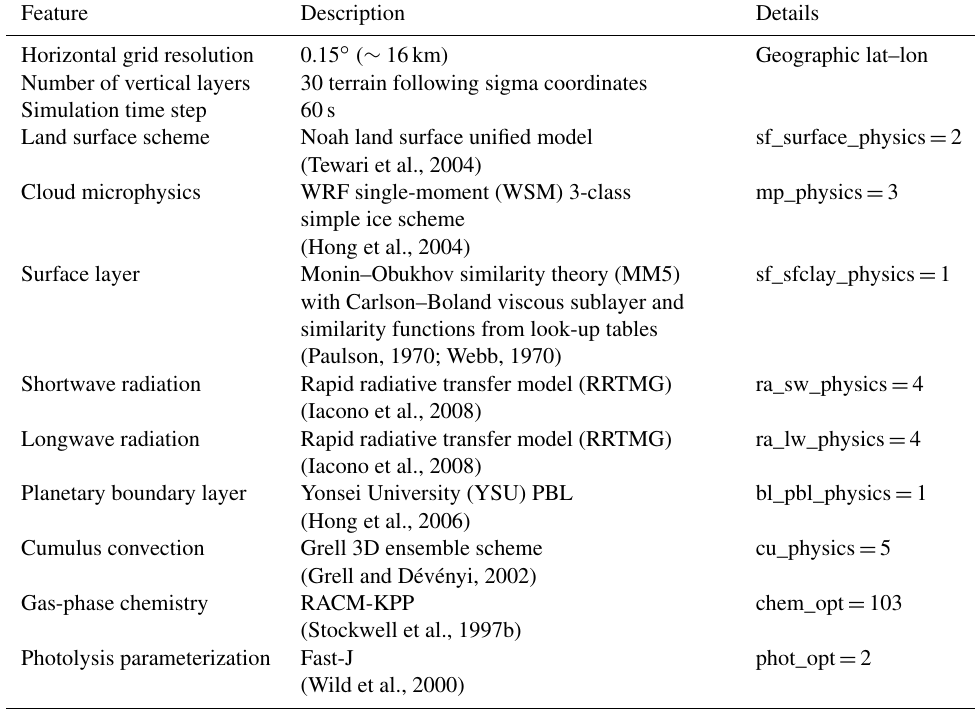
Table 3. Settings and physical parameterization schemes selected during the WRF-Chem